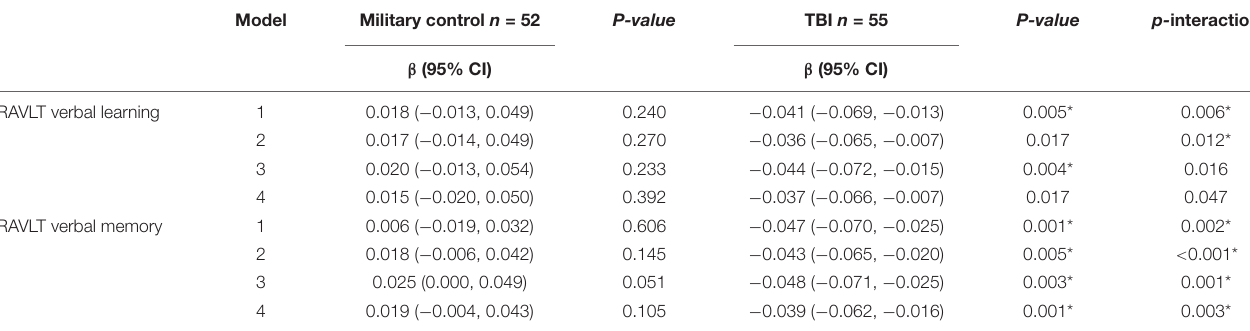
TABLE 3 | Multiple linear regression of CSO-PVS and cognitive test results: overall and stratified to traumatic brain injury (TBI) history.